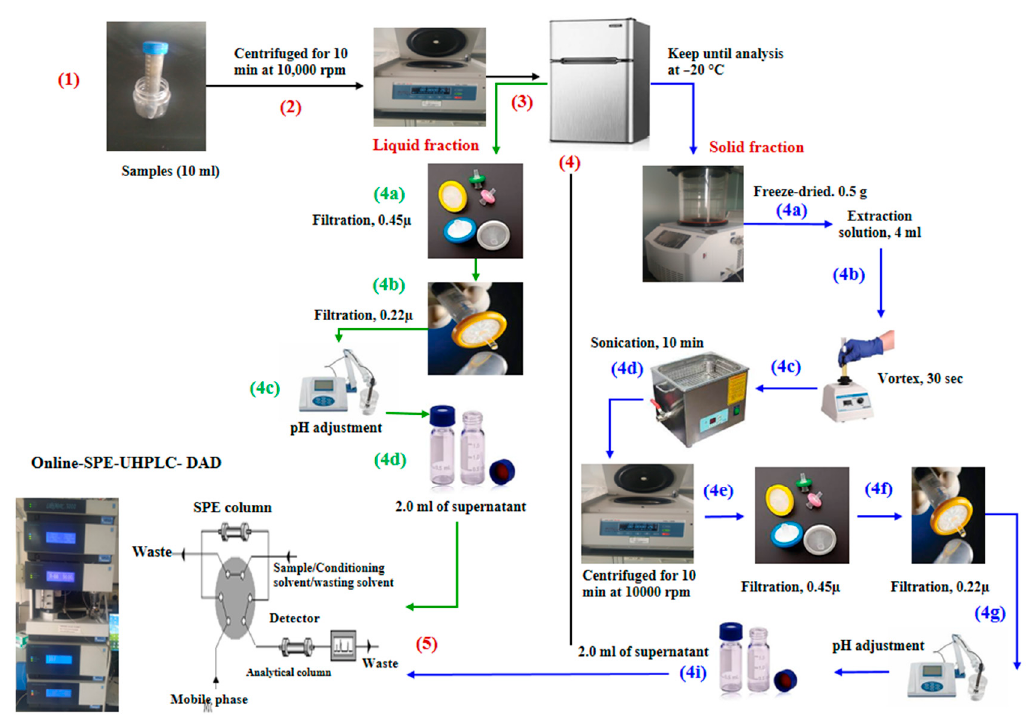
Figure 5. Scheme for the determination of targeted antibiotic residues in swine manure.